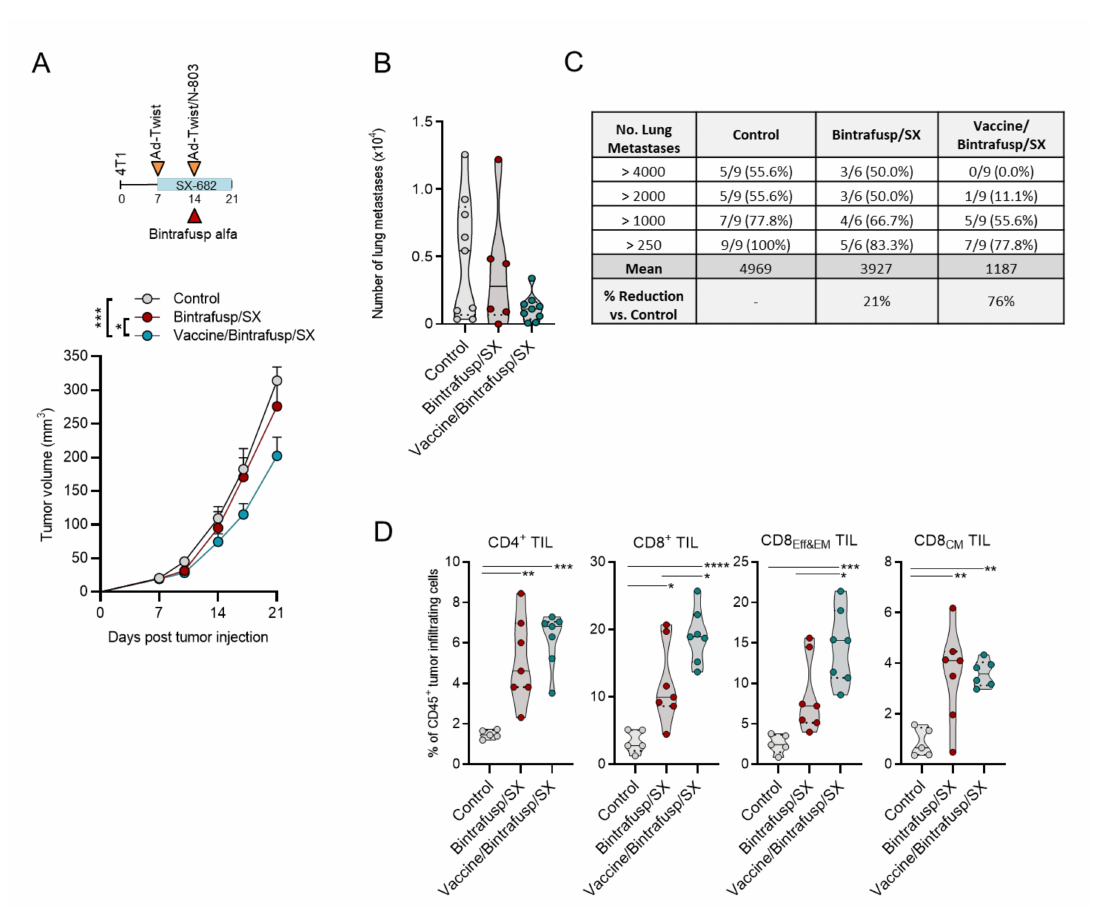
Figure 4. Vaccine synergizes with Bintrafusp alfa and SX-682 and increases TIL in 4T1 tumors. ( A ) BALB/c mice bearing 4T1 tumors in the mammary fat pad received control or SX-682 diet on day 7 (200 mg/kg body weight/day), with a priming vaccine dose of s.c. Ad-Twist (1 × 10 10 viral particles). On day 14, mice received an i.p. injection of 200 µ g bintrafusp alfa with a boosting vaccine dose of Ad-Twist/N-803 (1 × 10 10 viral particles, N-803, 1 µ g, s.c.). Graph shows average tumor growth and error bars indicate SEM of biological replicates; n = 6 (Control) or 7 (Bintrafusp/SX, Vaccine/Bintrafusp/SX) mice/group. Control indicates mice that were left untreated and fed a base diet without SX-682. * p ≤ 0.05; *** p ≤ 0.001 for two-way ANOVA. ( B ) Number of metastases quantified in the lungs of 4T1 tumor-bearing mice on day 21; individual points represent data from one mouse. ( C ) Table depicting the number and percentage of mice with the indicated range of lung metastases in each group, the mean number of metastases in each group, and the % reduction of the mean in each group vs. the Control group. Data are pooled from 2 independent experiments. ( D ) Tumors were harvested and analyzed by flow cytometry on day 21. Individual points represent data from one tumor. * p ≤ 0.05; ** p ≤ 0.01; *** p ≤ 0.001; **** p ≤ 0.0001 for one-way ANOVA followed by Tukey’s post hoc test. i.p. = intraperitoneal. s.c. = subcutaneous. TIL = tumor-infiltrating